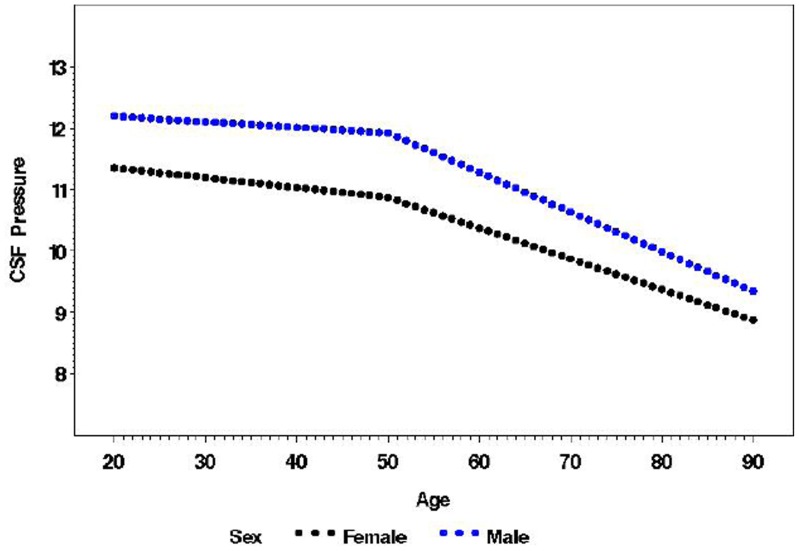
Segmented multivariate linear regression model CSFP (mm Hg) by age and sex.For each year of increase in age, CSFP decreased 0.009 mmHg (p = 0.132) for age <50 and by 0.056 mmHg, (p<0.001) for age greater than 50. Prior to age 50, the slope is not different between males and females (p = 0.369). After age 50, the gender difference in the slope is borderline significant (p = 0.067). The r2 of this model is 0.071.